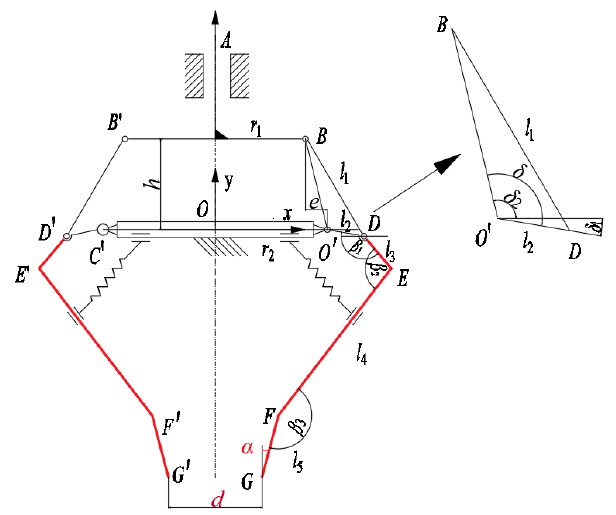
Figure 4. Motion diagram of manipulator. Note: r 1 is the distance between rod end point B and center point of middle moving block, mm; r 2 is the distance between end point of seedling claw O and center point of bottom frame O ′ , mm; h is the distance between center point of middle moving block and center point of bottom frame O ′ , mm; e is the distance between point B and point O , called the offset distance, mm; d is the distance between point G ′ and point G , mm; l 1 is the length of rod BD , mm; l 2 is the length of rod OD , mm; l 3 is the length of rod DE , mm; l 4 is the length of rod EF , mm; l 5 is the length of rod BD , mm; β 1 is the angle between OD and DE ( ◦ ); β 2 is the angle between EF and DE ( ◦ ); β 3 is the angle between EF and FG ( ◦ ); α is the angle between FG and the Y -axis ( ◦ ); δ 1 is the angle between O ’ D and the X -axis ( ◦ ); δ 2 is the angle between O (cid:48) D and O (cid:48) B ( ◦